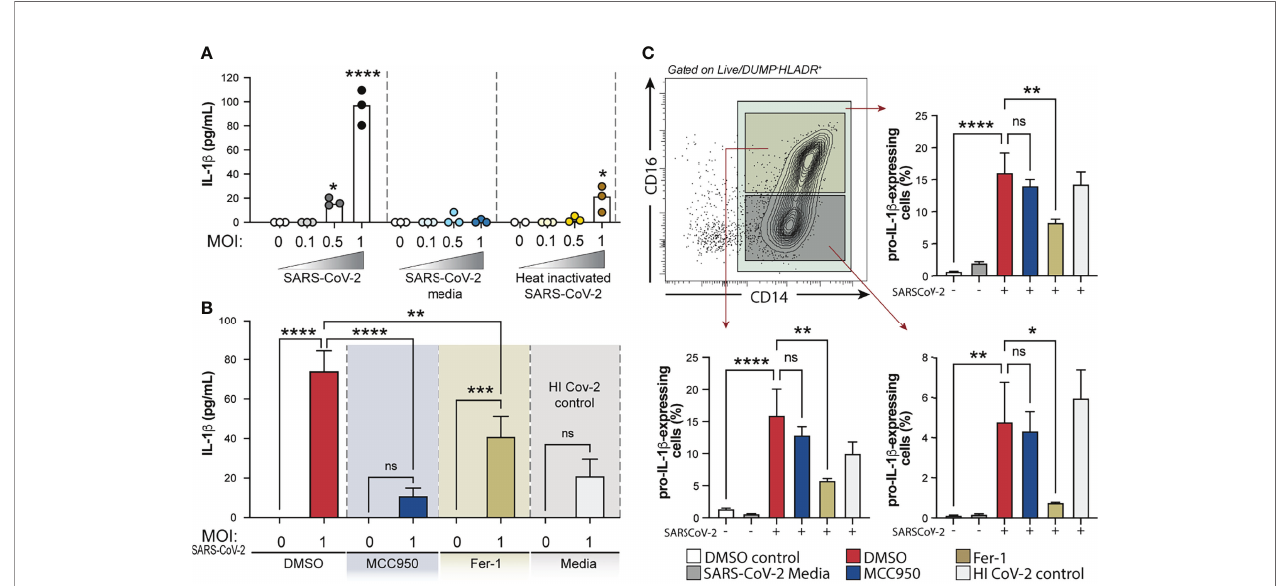
FIGURE 6 | Exposure of human healthy control monocytes to SARS-CoV-2 in vitro induces IL-1 b by a mechanism involving both in fl ammasome activation and lipid peroxidation. (A) Elutriated monocytes isolated from fresh healthy donors PBMCs were co-cultured with live SARS-CoV-2 (USA-WA1/2020) at distinct MOIs (0.1, 0.5 or 1), media only (DMSO control), VERO E6-media only (SARS-Cov-2 media), VERO E6-media containing SARS-CoV-2 (SARS-Cov-2) or heat inactivated SARS-CoV-2 (HI CoV-2 control) and IL-1 b levels were measured in the culture supernatants after 24 h by ELISA. Data represent the means ± SEM of triplicate samples. Statistical signi fi cance was assessed by one-way ANOVA analysis for the indicated experimental conditions. *P < 0.05, ****P < 0.0001. (B) Healthy donor monocytes were incubated with SARS-CoV-2 at MOI of 1 and treated or not with NLRP3 inhibitor, MCC950 (10 m M) or lipid peroxidation inhibitor, Fer-1 (10 m M). IL-1 b levels were measured in culture supernatants after 24 h by ELISA. Data represent the means ± SEM of 2 independent experiments pooled with 5 – 6 replicates. Statistical signi fi cance was assessed by one-way ANOVA analysis for the indicated experimental conditions. **P <0.01, ***P < 0.001, ****P < 0.0001. (C) Representative FACS plot showing the distribution of healthy donor monocyte subsets de fi ned by CD14 and CD16 markers (gated on Live/Dead low HLADR + CD2 − CD3 − CD19 − CD20 − CD56 − CD66 − ) after exposure to VERO E6-media containing SARS-CoV-2 in vitro . Percentage of total monocytes or CD14 high CD16 + and CD14 high CD16 − cells expressing pro-IL1 b was compared among the distinct experimental conditions. Data represent the means ± SEM of two independent experiments in quadruplicate. Statistical signi fi cance was assessed by one-way ANOVA analysis for the indicated experimental conditions. *P < 0.05, **P < 0.01, ****P < 0.0001, ns , not signi fi